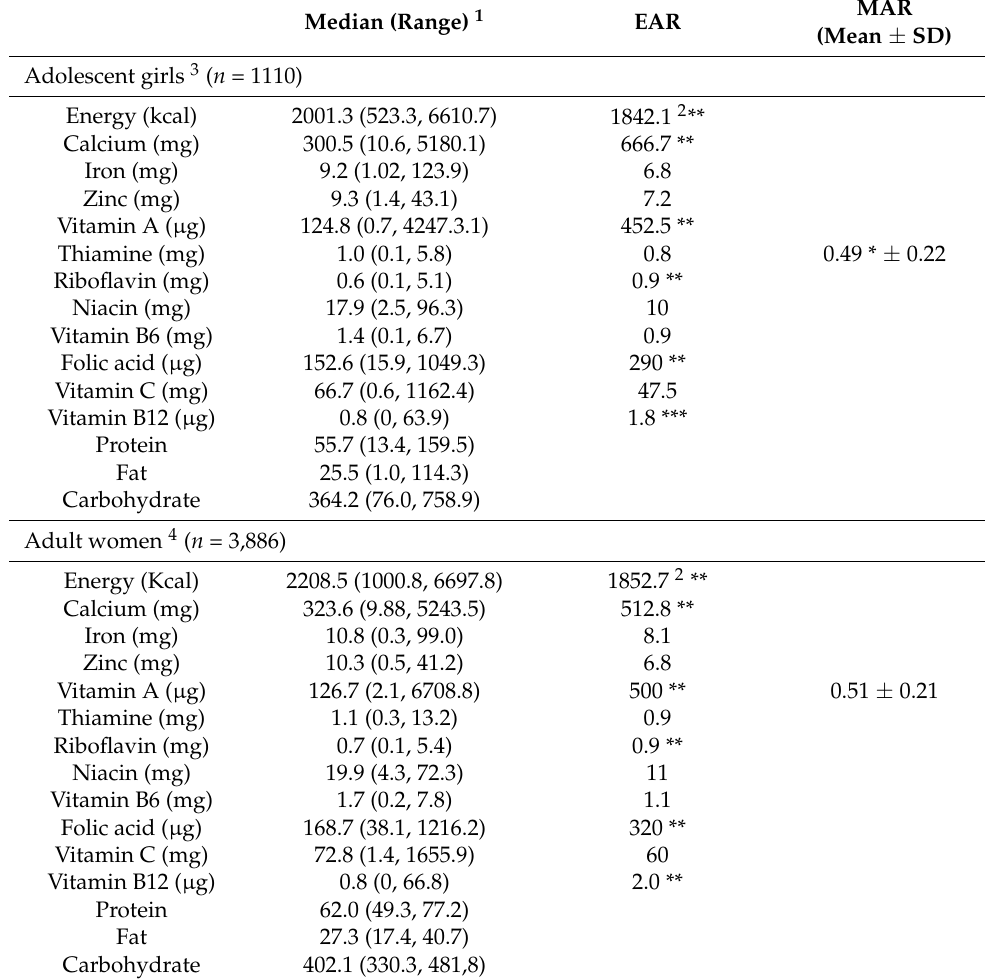
Table 2. Dietary nutrient intakes of adolescent girls and adult women in the preceding 24